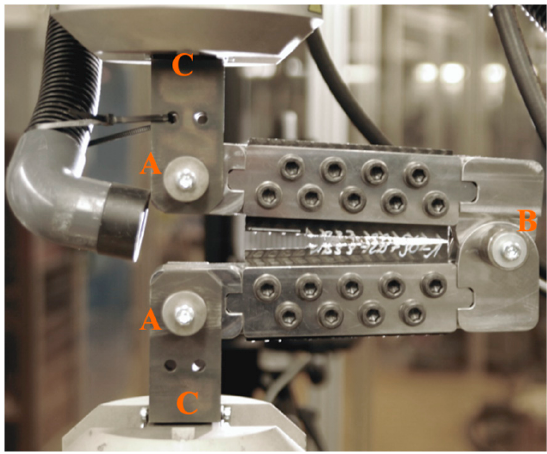
Figure 2. Braided specimen in the test rig. ( A , B ) are hinges, ( C ) are the grips of the